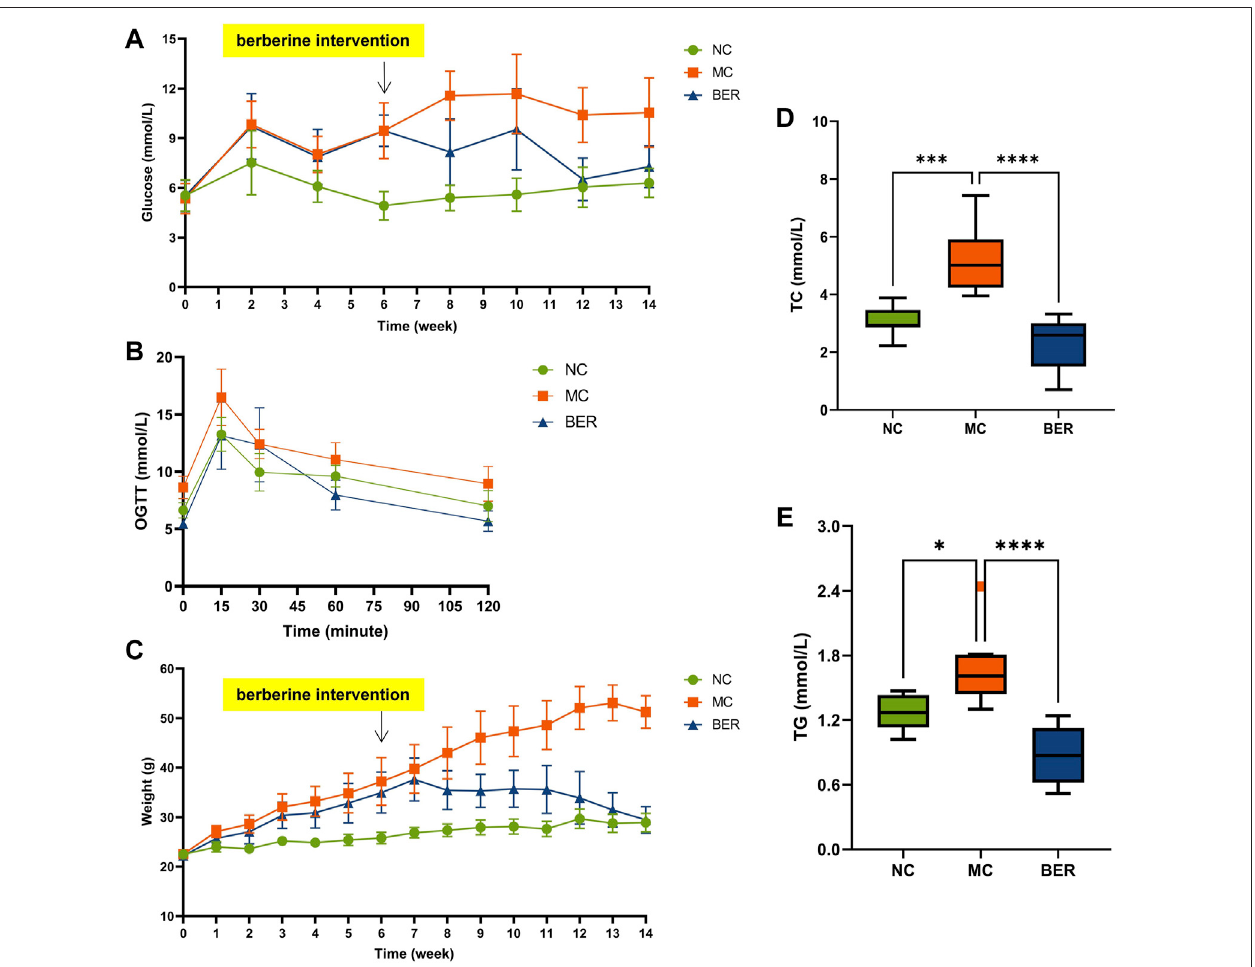
FIGURE1| Berberine improves glucoseand lipidmetabolism. (A) fasting bloodglucose (FBG). (B) oralglucose tolerance test(OGTT) after 14 weeksoftreatment. (C) weight. (D) totalplasmacholesterol(TC). (E) triglyceride(TG).Dataarepresentedasmeans±standarderrorsofthemeans(SEM).**** p < 0.0001,*** p < 0.001,** p < 0.01, * p <